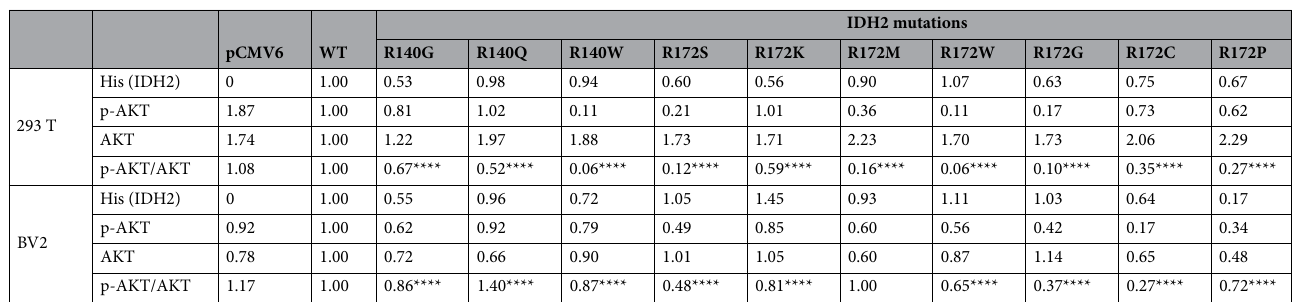
Table 1. Expression quantitations of IDH2 (His), p-AKT, and AKT in 293T and BV2 cell lines at 48 h post- transfection with IDH2 WT and point mutant constructs. * p < 0.05, ** p < 0.01, *** p < 0.001, and **** p <